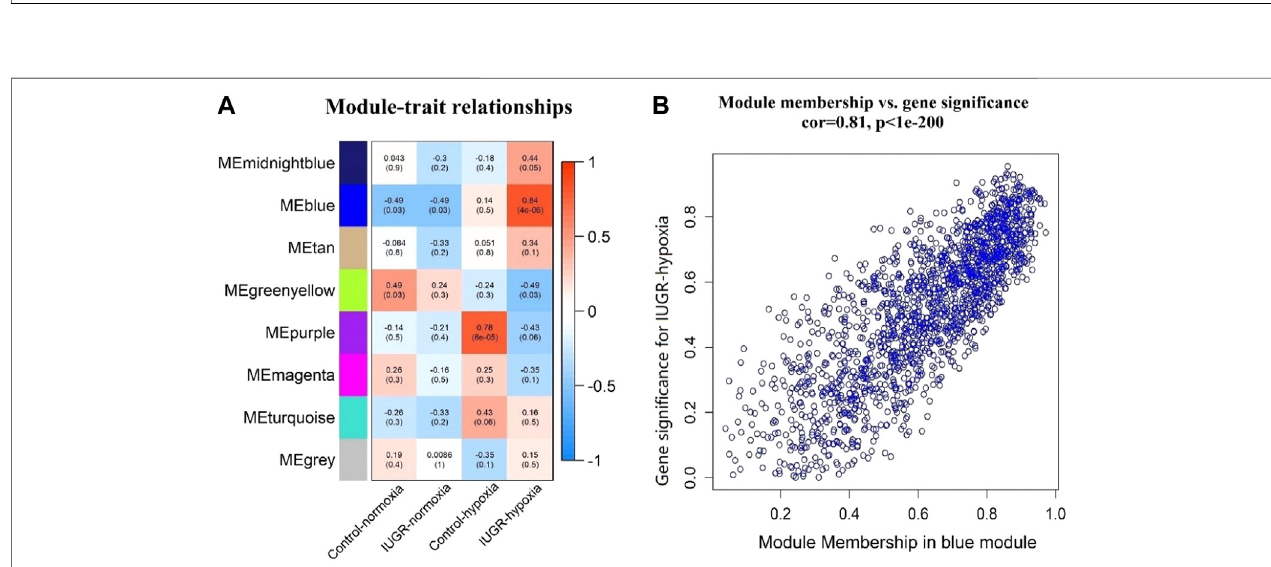
FIGURE3| Divisionandvalidationofco-expressionmodules. (A) Clusterdendrogramoftheidenti fi edco-expressionmodules.Theidenti fi edmoduleswerecoded by colors indicated below the dendrogram. The upper one presents the fi rst set of modules obtained from the dynamic tree cut algorithm, while the lower one presents the merged modules according to Pearson ’ s correlation analysis. (B) Network heatmap plot showing topological overlaps, with light colors denoting low adjacency and darker colors denoting higher adjacency.